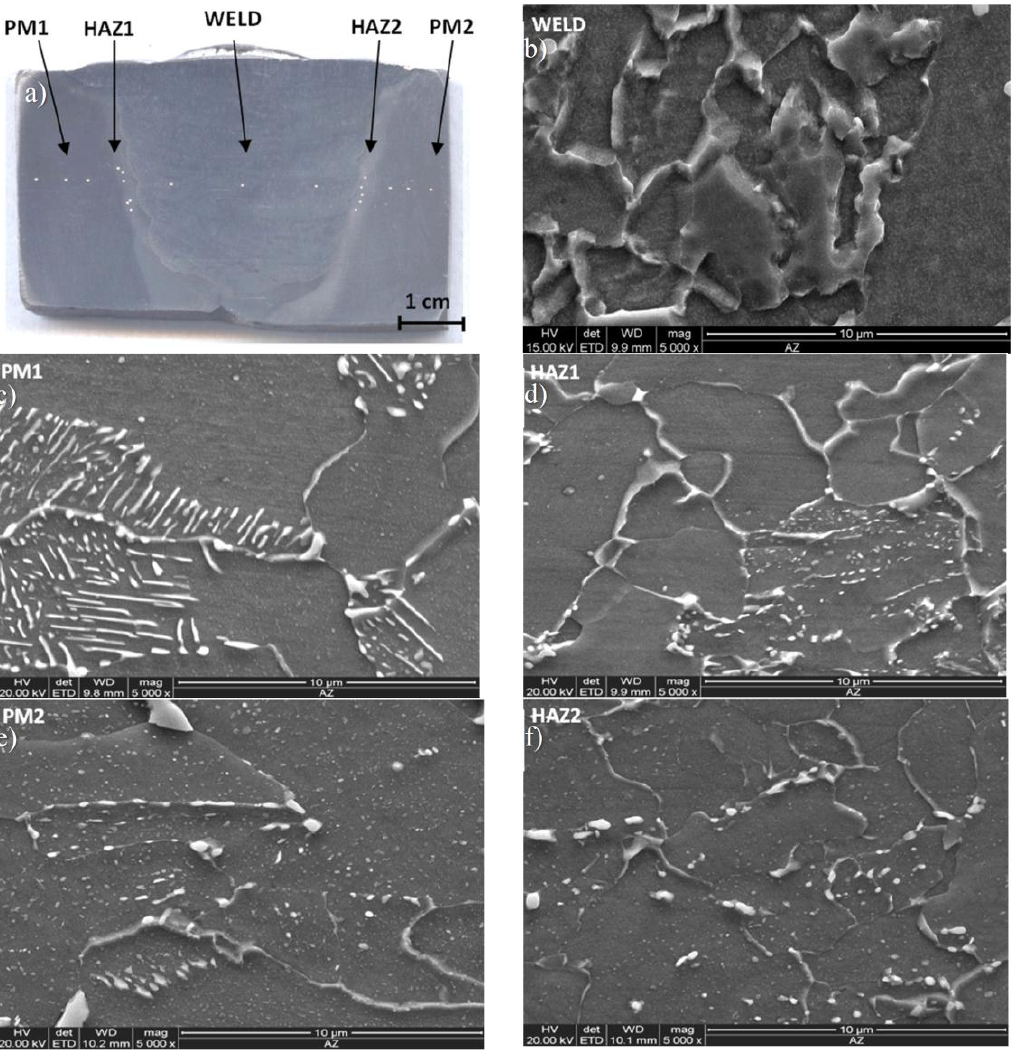
Ferritic-bainitic structure. No discontinuities or micro-cracks are observed in the structure. Bainitic areas: class 0; precipitates: class 0; Damaging processes: class 0. MATERIAL CONDITION: CLASS 0; EXHAUSTION